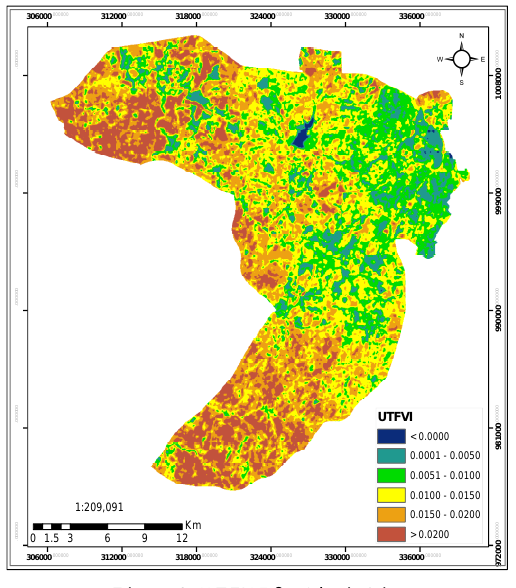
Figure 6: UTFVI for Abuja City